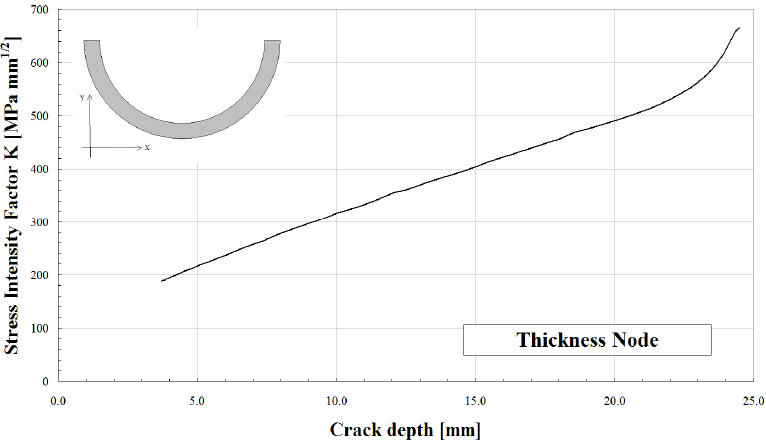
Figure 28: Stress intensity factor vs . crack depth